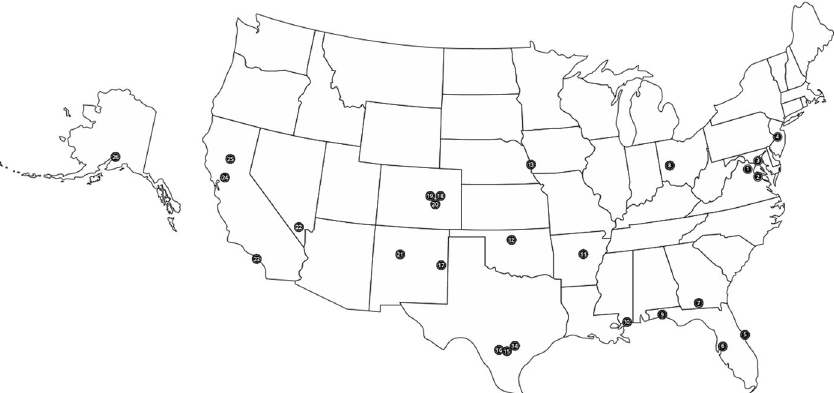
Fig. 1 1 DHHQ, Falls Church, VA; 2 Andrews AFB; 3 Bolling AFB; 4 JBMDL; 5 Patrick AFB; 6 MacDill AFB; 7 Moody AFB; 8 Wright Patterson AFB; 9 Eglin AFB; 10 Keesler AFB; 11 Little Rock AFB; 12 Vance AFB; 13 Offutt AFB; 14 Randolph AFB; 15 Air Force Medical Operations Agency; 16 Lackland AFB; 17 Cannon AFB; 18 Schriever AFB; 19 Peterson AFB; 20 United States Air Force Academy; 21 Kirtland AFB; 22 Nellis AFB; 23 Los Angeles AFB; 24 Travis AFB; 25 Beale AFB; 26 Elmendorf